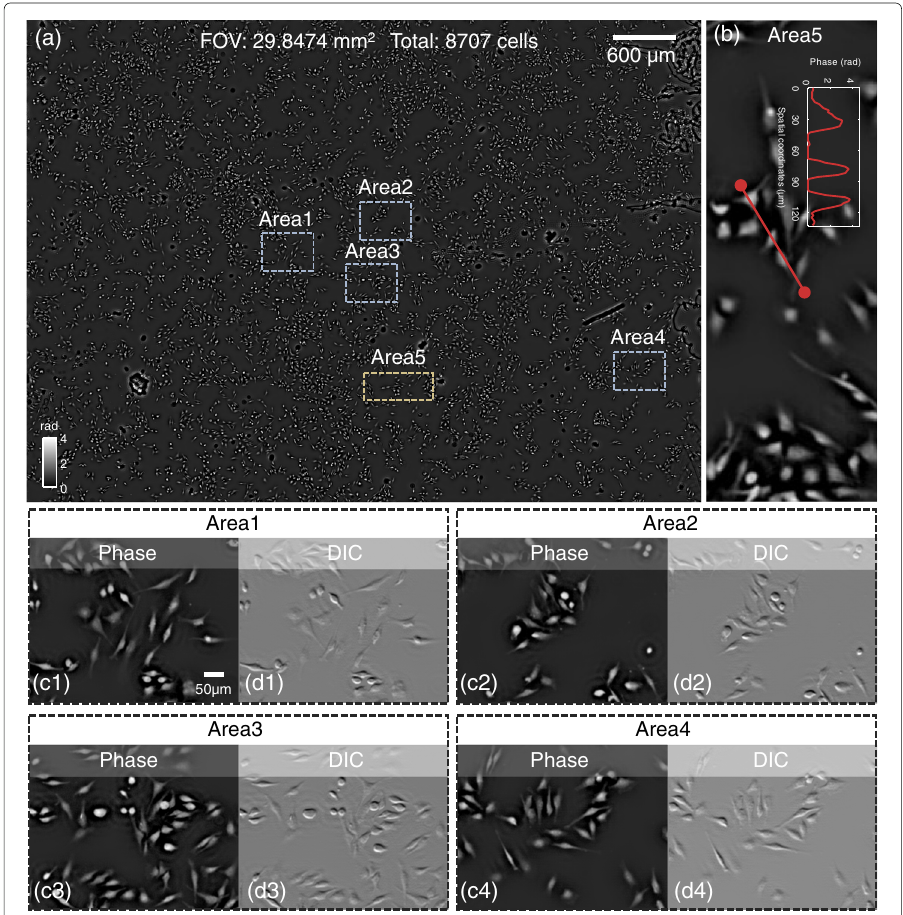
Fig. 29 High-throughput reconstructed quantitative phase of HeLa cells. (a) Reconstructed quantitative phase of HeLa cells in full FOV of 29.8474 mm 2 . (b) The enlarged image of Area5 in (a) and the quantitative profile of cells. (c1)-(c4) The enlarged images of Area1, Area2, Area3, Area4 in (a). (d1)-(d4) Phase gradient images of Area1, Area2, Area3, Area4 generated from reconstructed quantitative phase by digital DIC